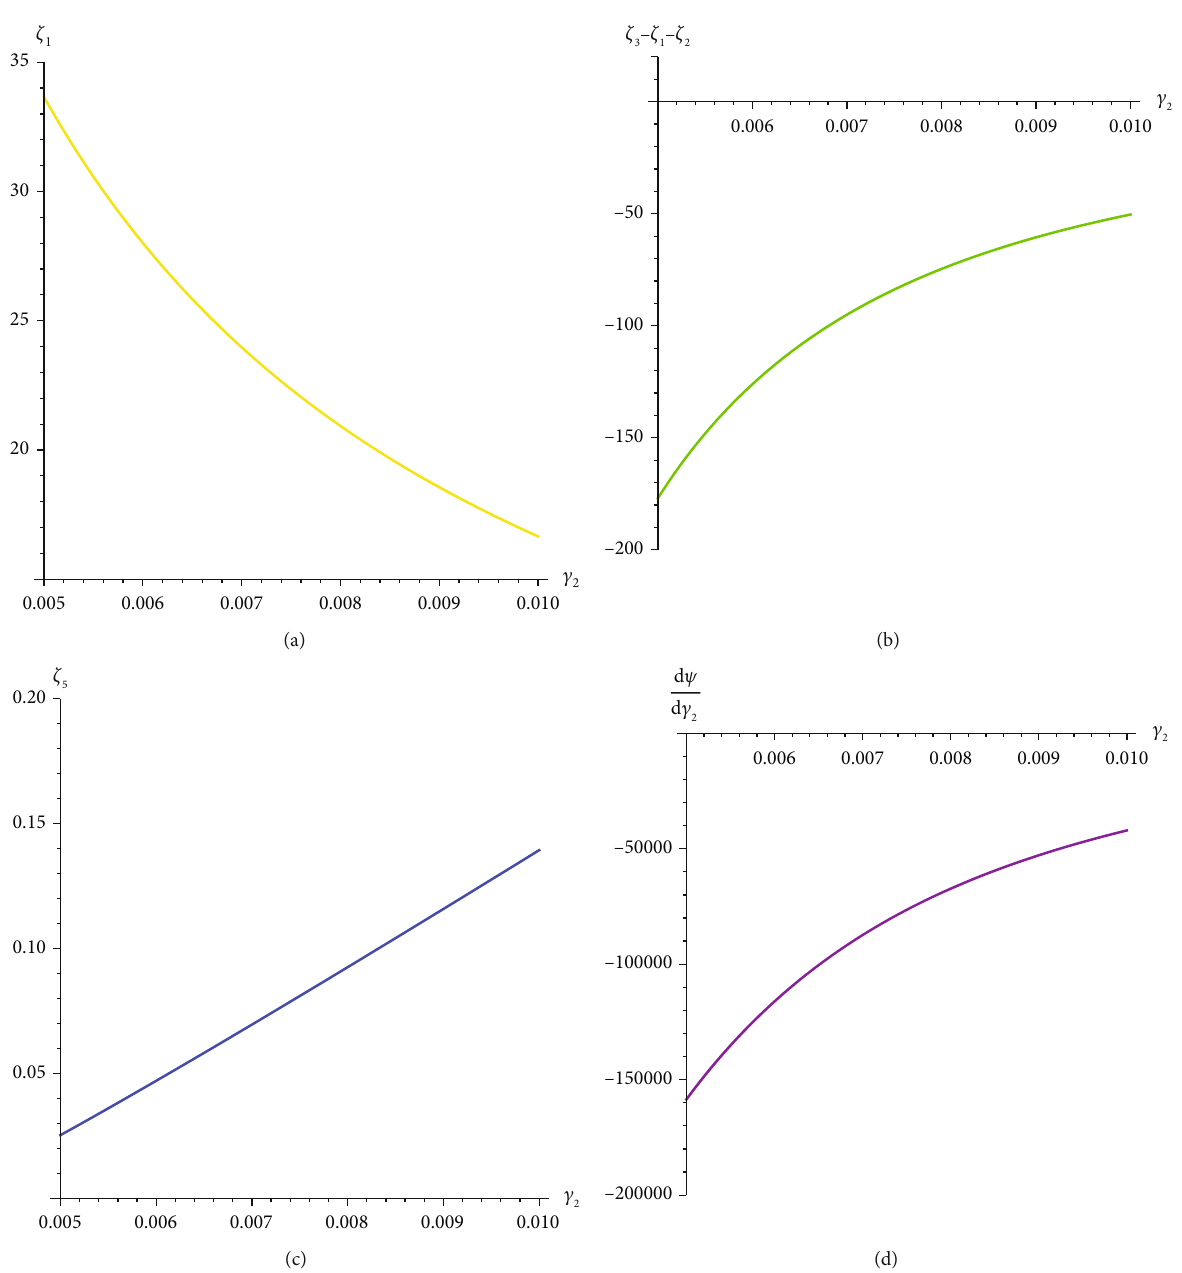
Figure 6: Plots for parameter γ